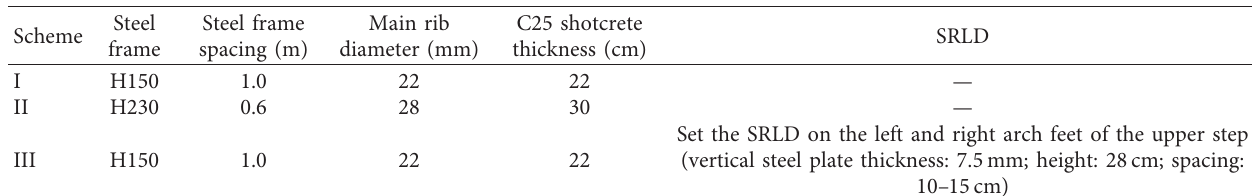
Figure 8: Damage of primary lining in the deep-buried loess tunnel. (a) Concrete cracking. (b) Steel frame twisted. Table 1: Statistical table of displacement monitoring results.